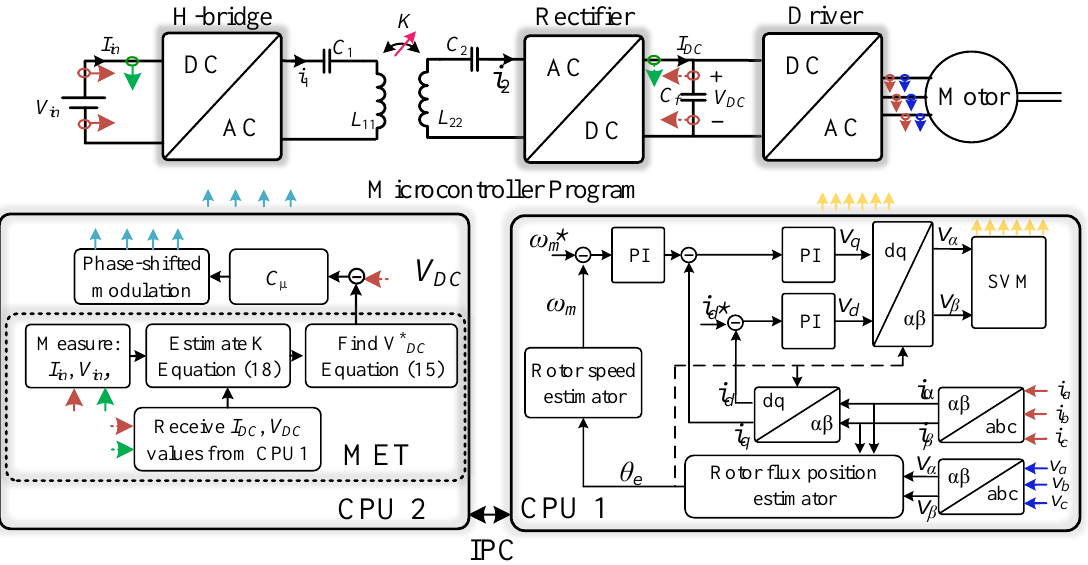
Figure 12. Control block diagram of the system, including the motor driver and WPT system.